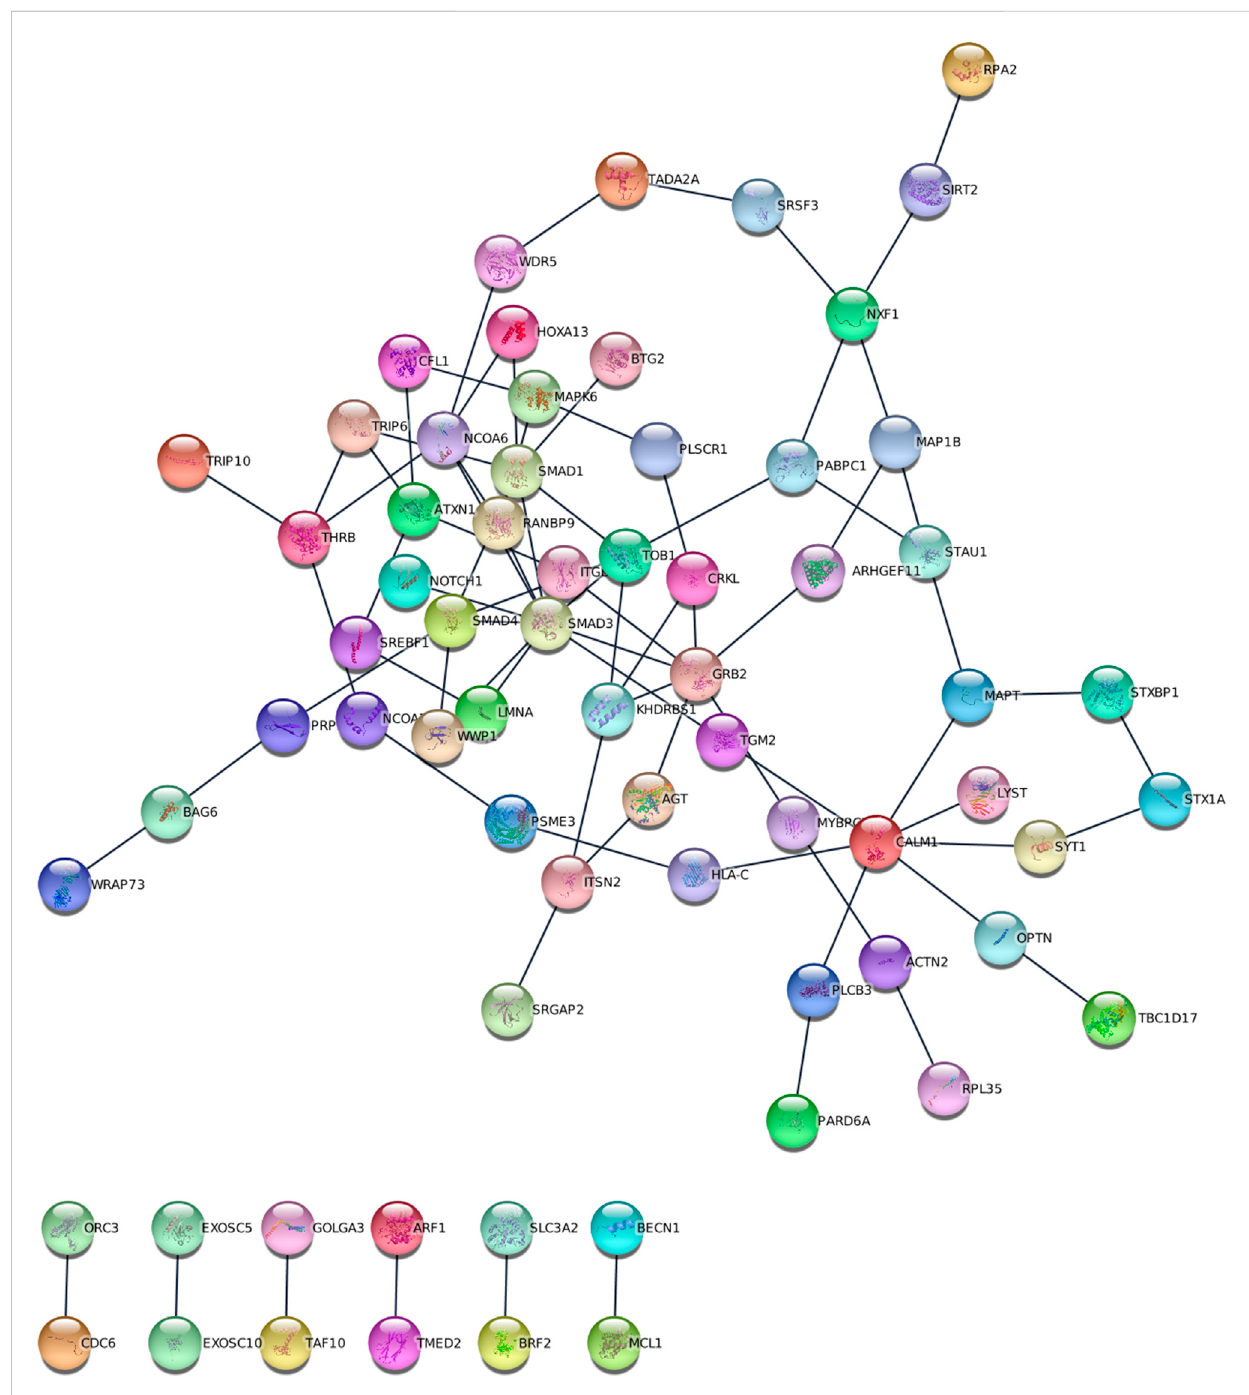
FIGURE 3 Visualisation of the 98 sub-network genes associated with the derived common